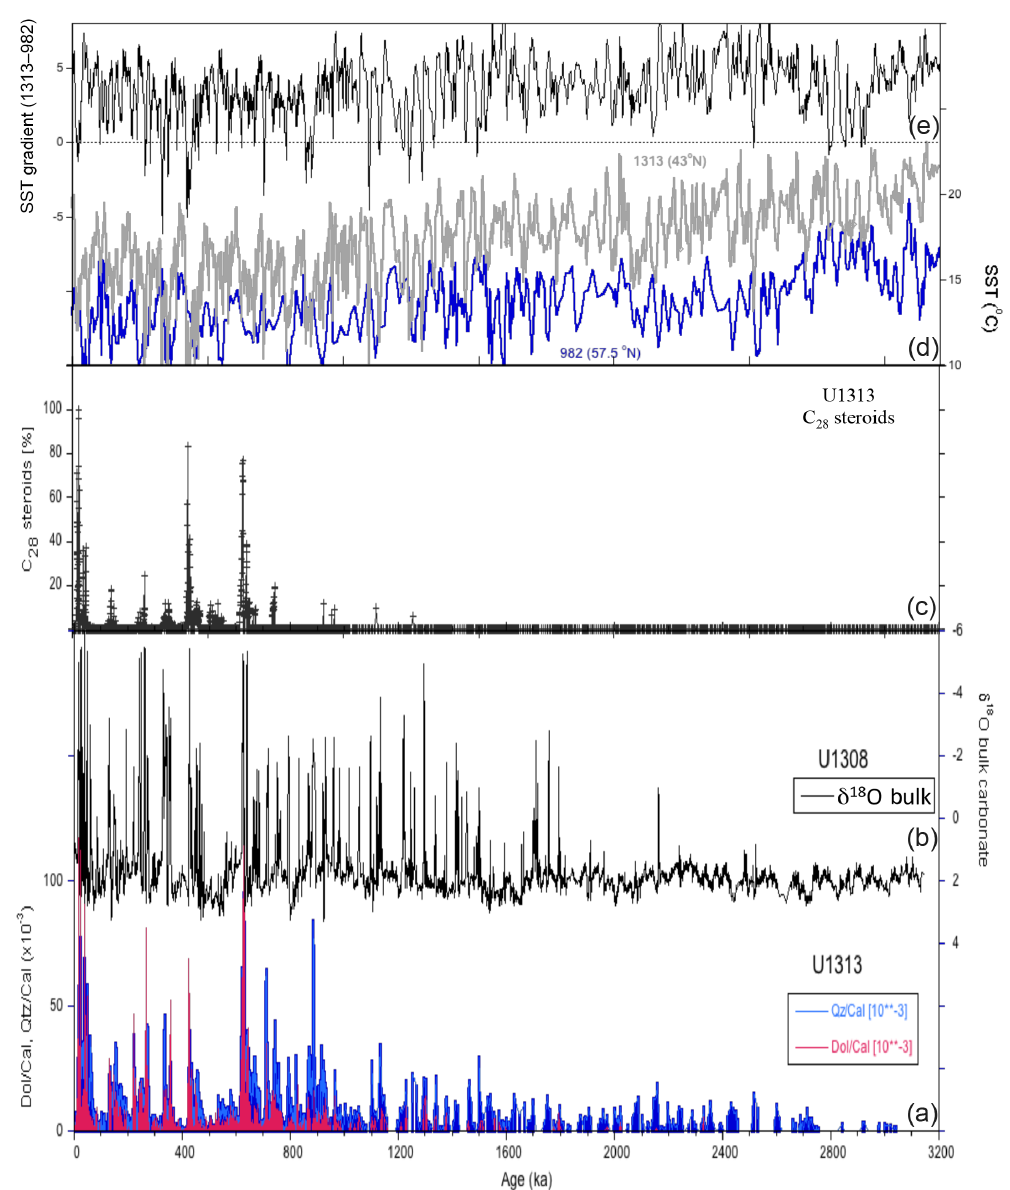
Figure 10. Comparison of the (a) quartz/calcite (Qtz/Cal, blue) and dolomite/calcite (Dol/Cal, red) ratios. (b) Bulk carbonate δ 18 O at Site U1308 (black). (c) Occurrence of C28 steroids (a petrogenic compound indicative of input from Hudson Strait) at Site U1313 (Naafs et al., (cid:48) 2013). (d) Alkenone (U k ) sea-surface temperature at Site U1313 (gold; Naafs et al., 2012) and 982 (blue; Lawrence et al., 2009). (e) The 37 sea-surface temperature gradient between U1313 and 982 calculated by subtracting values for each record interpolated at 1kyr intervals.